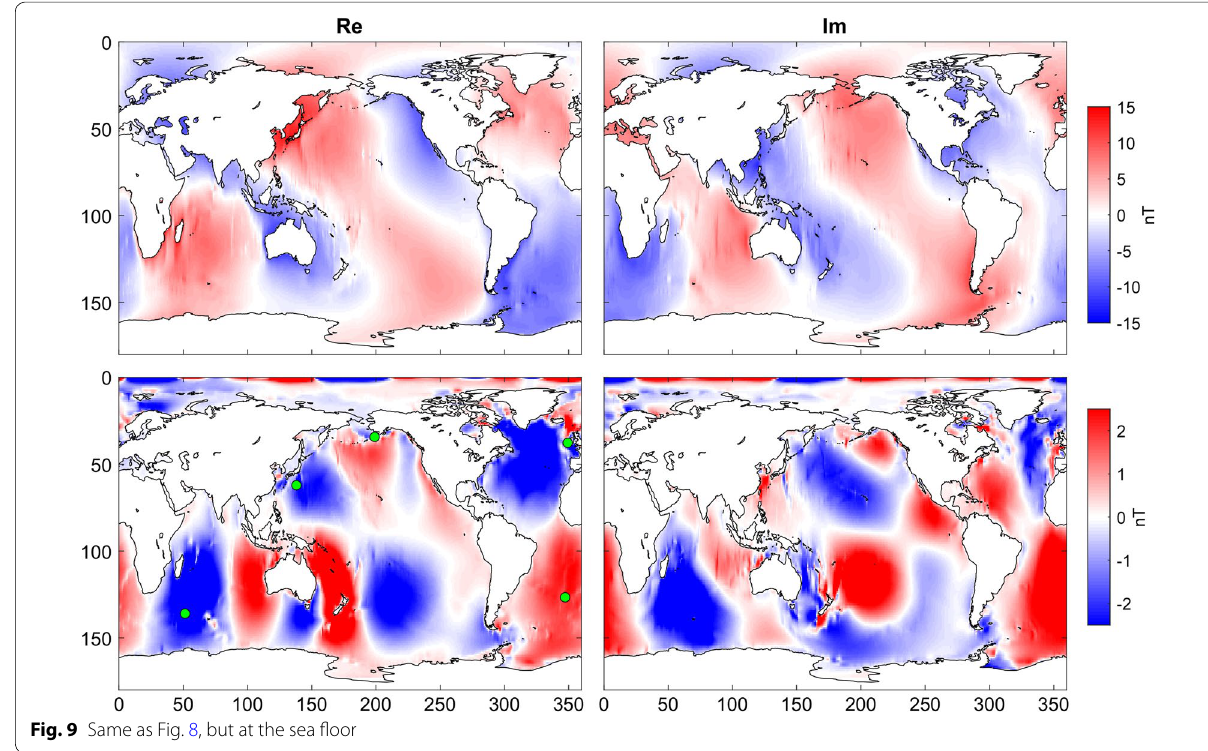
Fig. 9 Same as Fig. 8, but at the sea floor